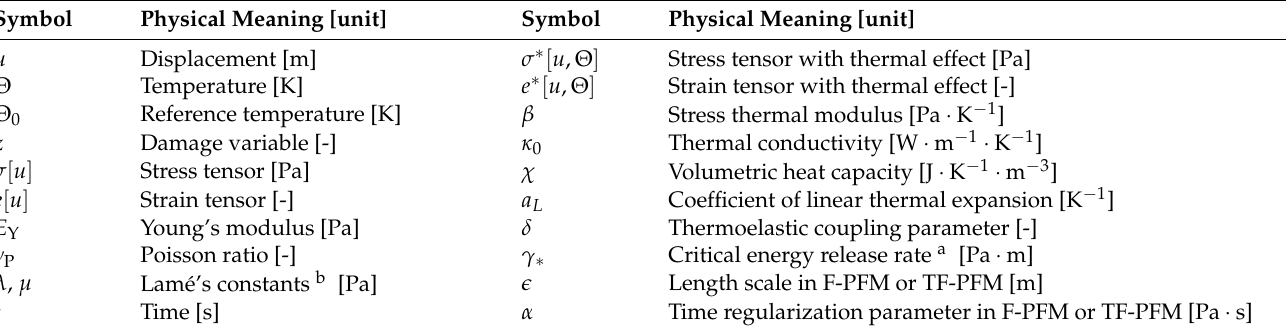
Table 3. List of physical